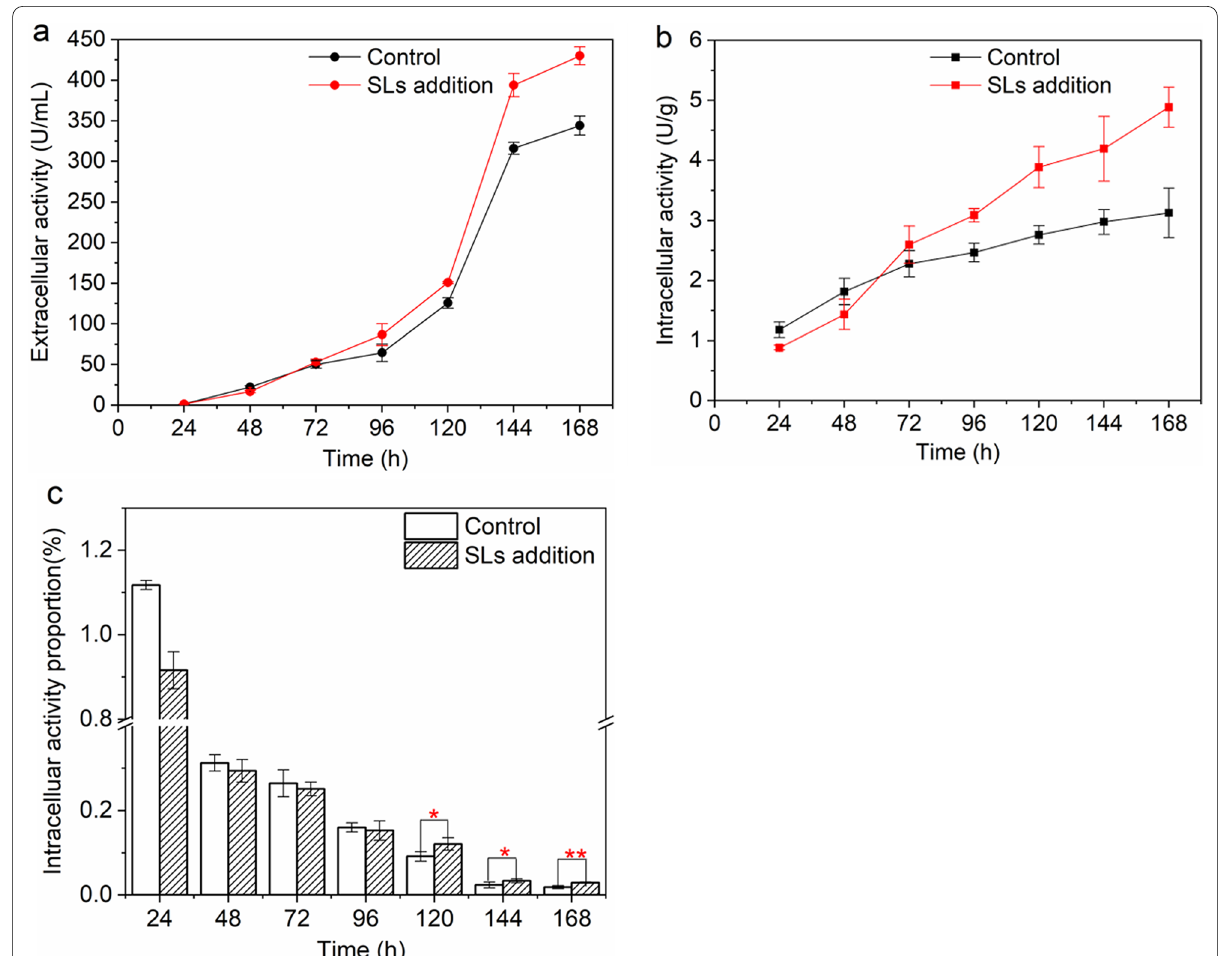
Fig. 2 Comparison of RML activities between control group and SLs addition group. a Extracellular activity. b Intracellular activity. c Intracellular activity proportion (*: 0.01 < P 0.05; **: P 0.01) When the intracellular activity proportion was calculated, the units of intracellular and extracellular ≤ ≤ enzyme activity had been normalized into units in the whole fermentation